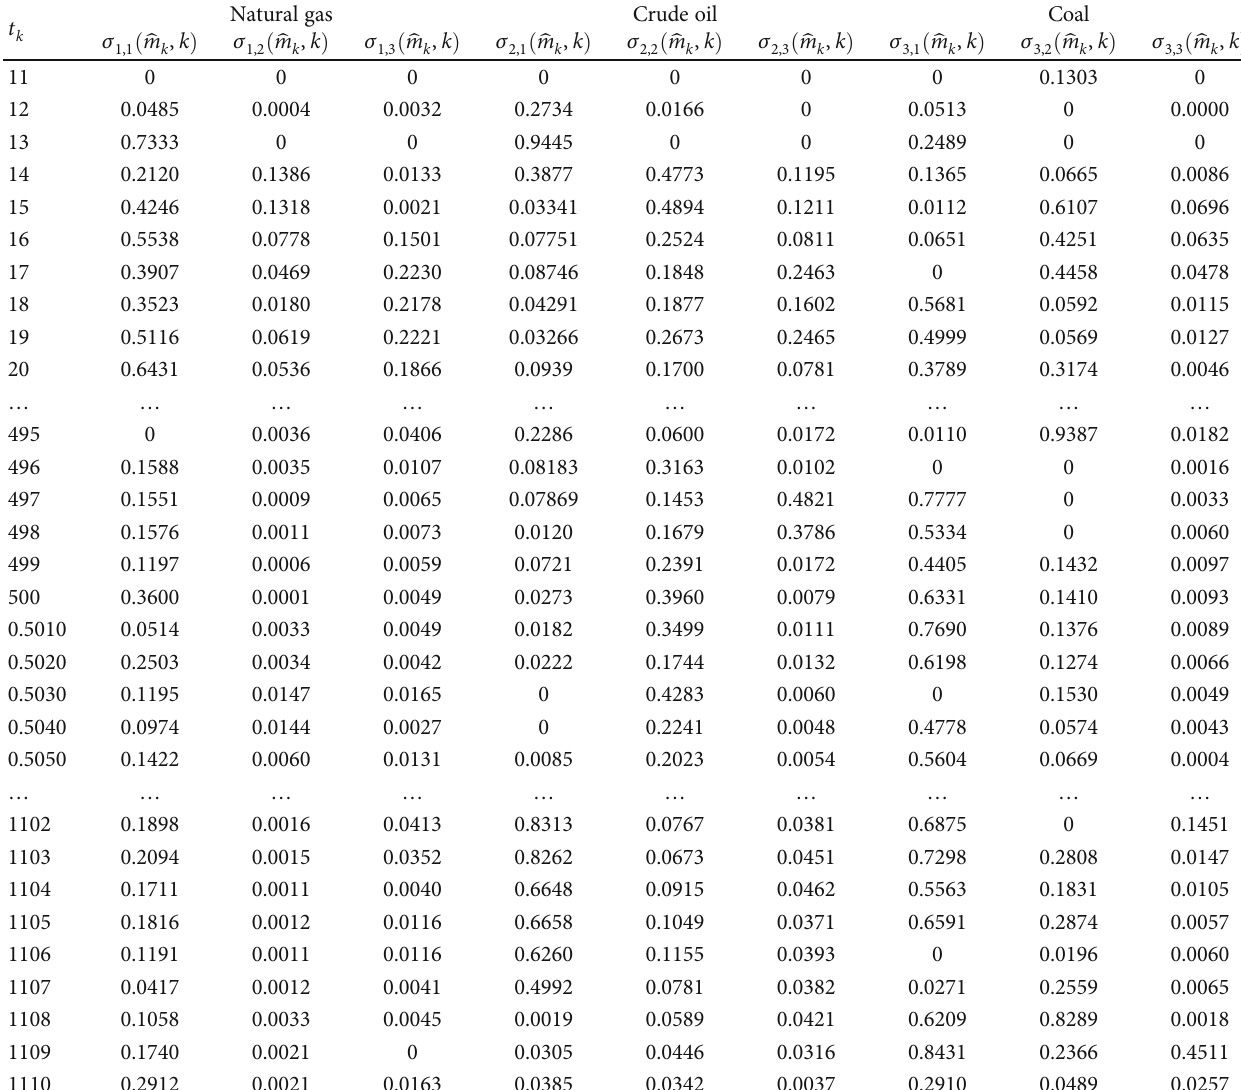
ð ̂ m , k Þ , σ 1,1 k